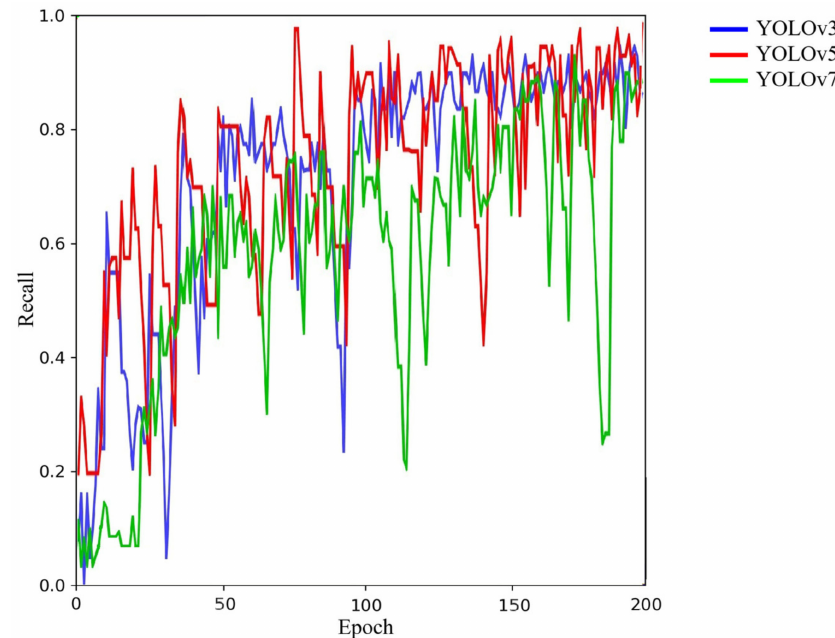
Figure 12. Recall